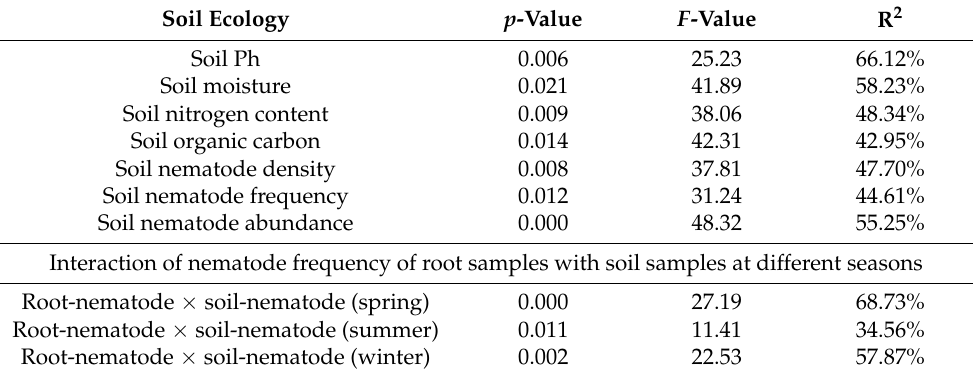
Table 1. One-way ANOVA analysis of soil ecology—pH, moisture, nitrogen content, and carbon content; soil nematode traits—density, frequency, and abundance; and interaction between soil and root nematodes.